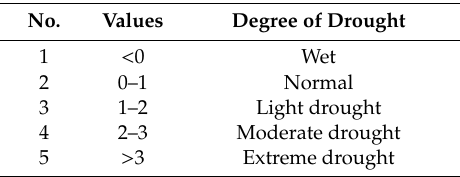
Table 1. Classification of drought according to the Ped